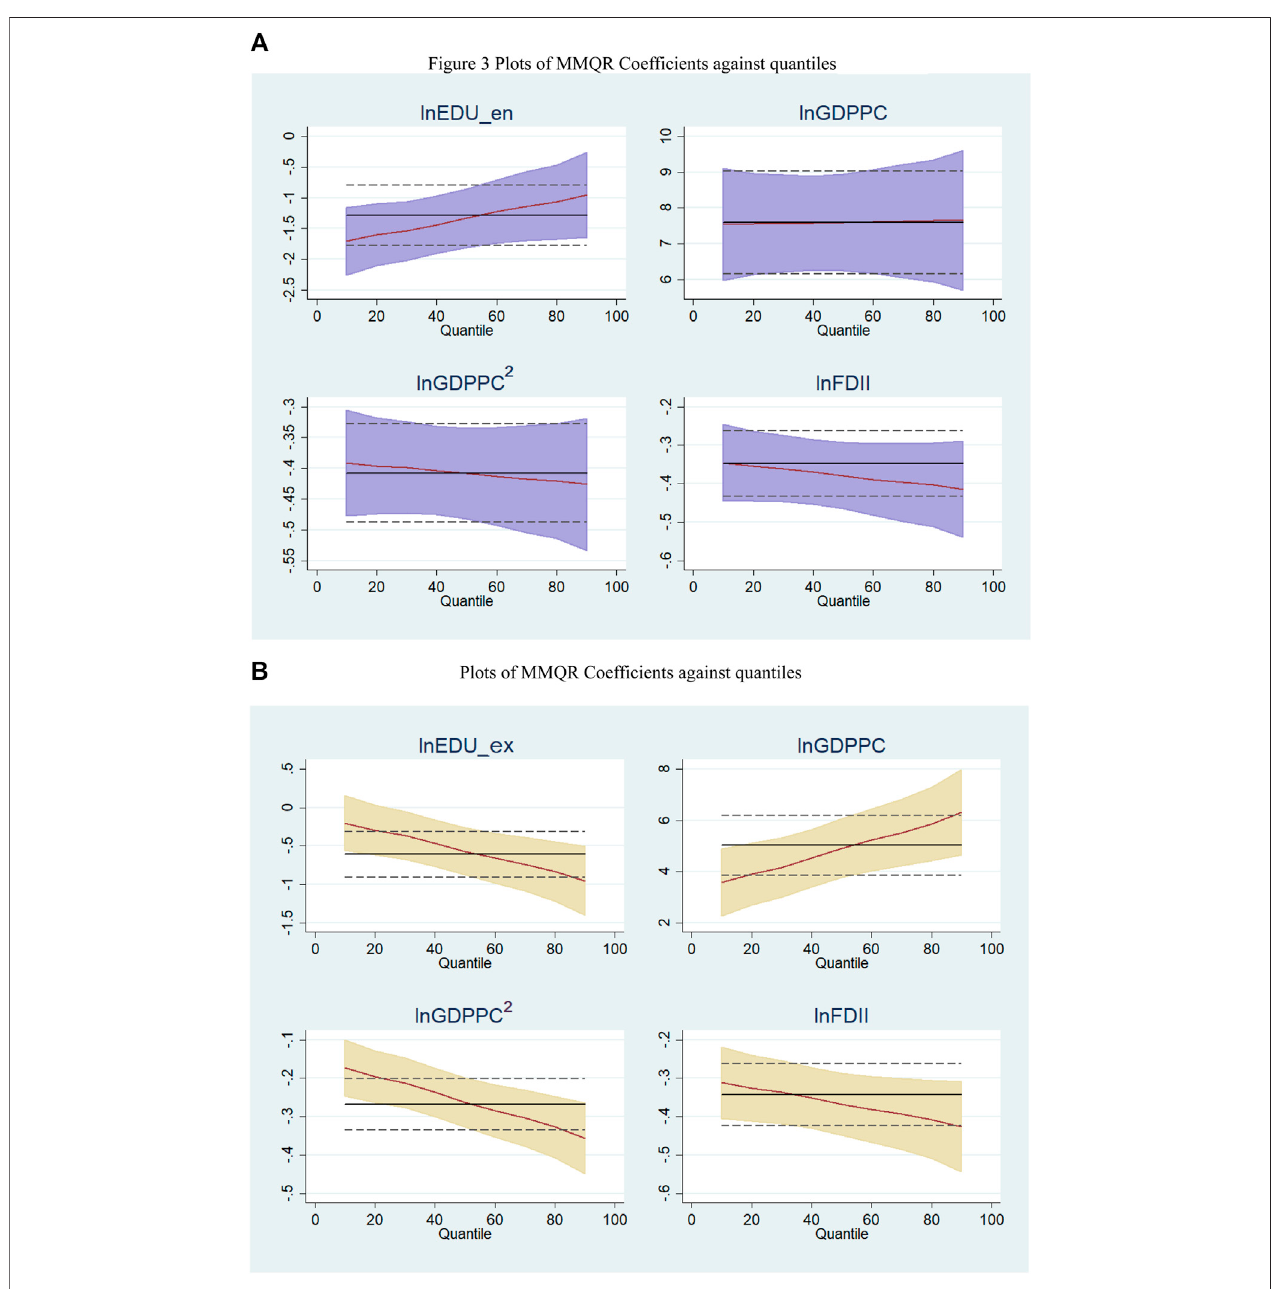
FIGURE 3 | Plots of MMQR coef fi cients against quantiles (A) . Plots of MMQR Coef fi cients against quantiles (B)